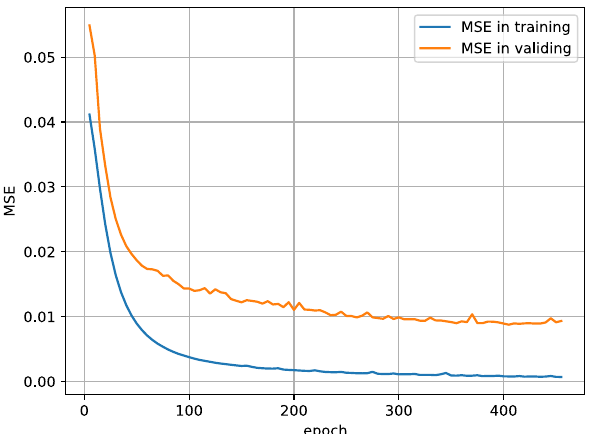
Figure 3. The change of MSE in the model. An epoch means training the neural network with all the training data for one